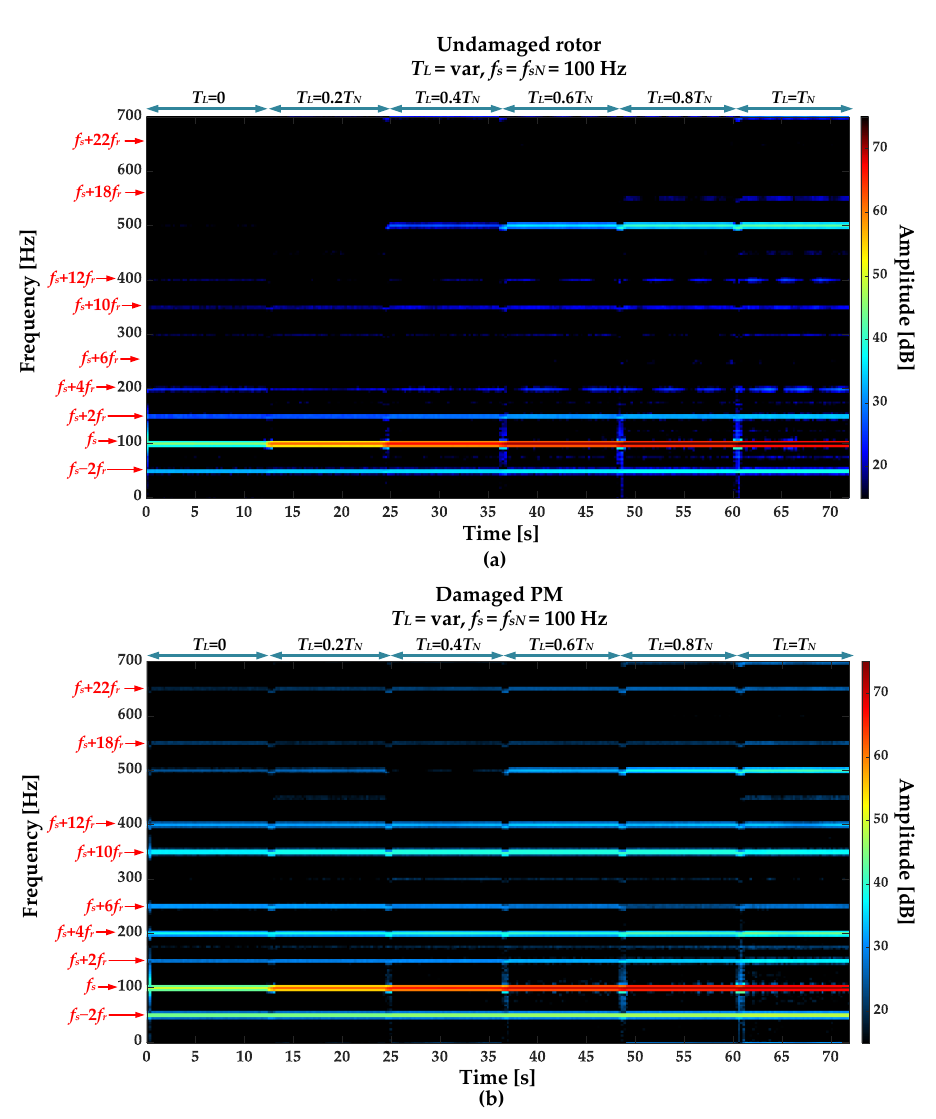
Figure 8. STFT spectrograms of the stator phase current component for ( a ) an undamaged rotor and ( b ) rotor with damaged PMs ( T L = var, f s = f sN = 100 Hz).